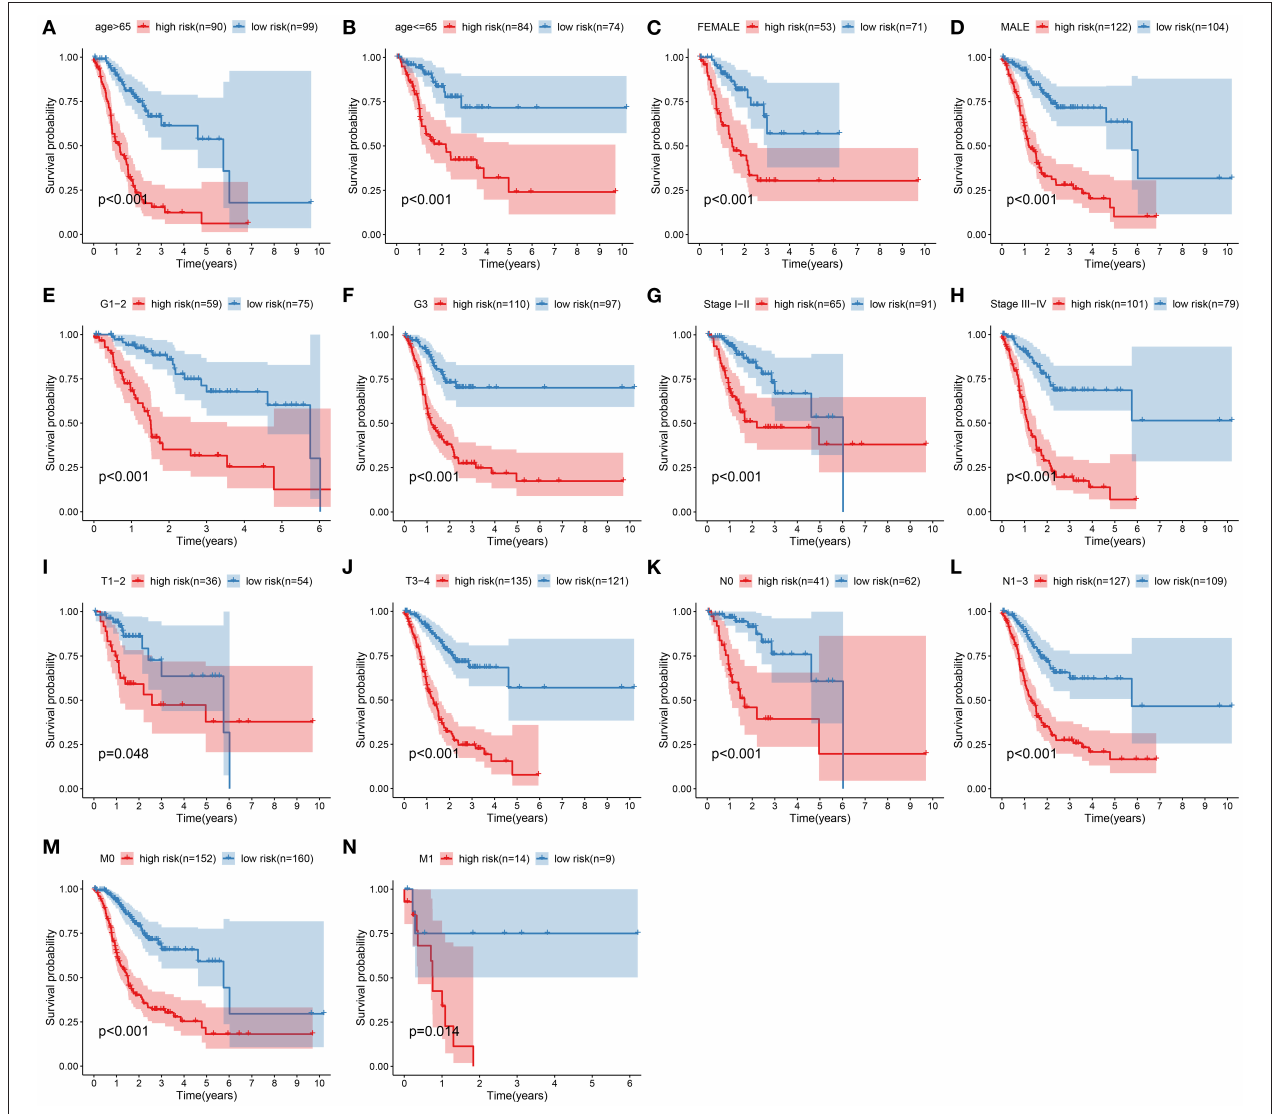
FIGURE 4 | Subgroup analysis of the signature in predicting gastric cancer patients’ survival. Kaplan–Meier curves for high- and low-risk subjects in different subgroups including (A) age > 65, (B) age ≤ 65; (C) female, (D) male; (E) grades 1–2, (F) grade 3; (G) stages I–II, (H) stages III–IV; (I) T1–2, (J) T3–4; (K) N0, (L)